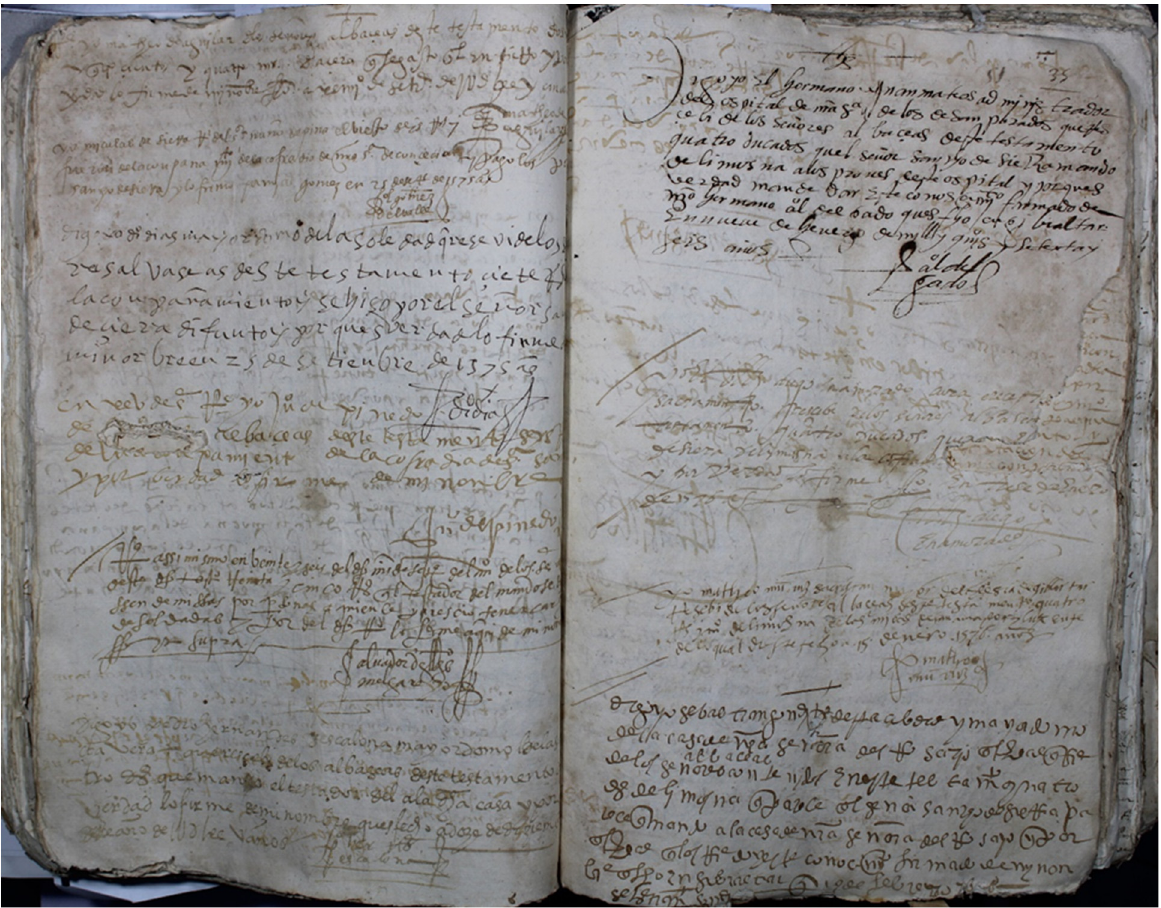
Figure 8. Some of the receipts attached to Sancho de Sierra’s will. AHPC, PNSR 153, ff. 50v-51r. Reproduced with the permission of the Archivo Histórico Provincial de Cádiz [© Archivo Histórico Provincial de Cádiz].